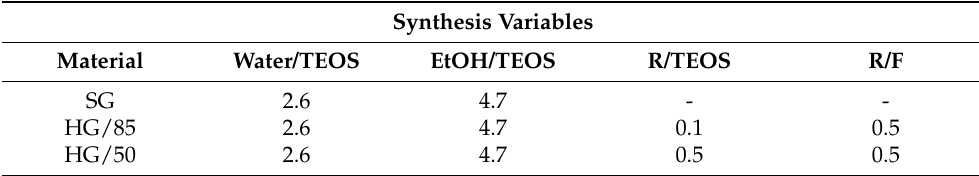
Table 1. Molar ratios employed in the synthesis of silica and C-Si hybrid